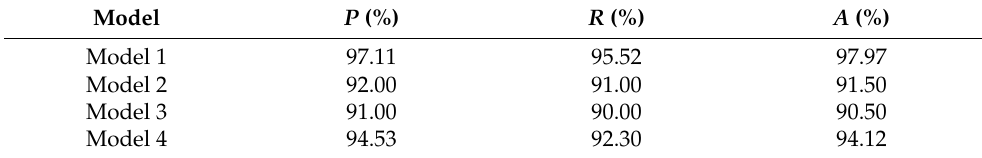
Figure 3. Frames with a scale factor 1, 2, 4, 8, and 16. Table 1. Performance comparison between 2, 4, 8, and 16 frames using our proposed